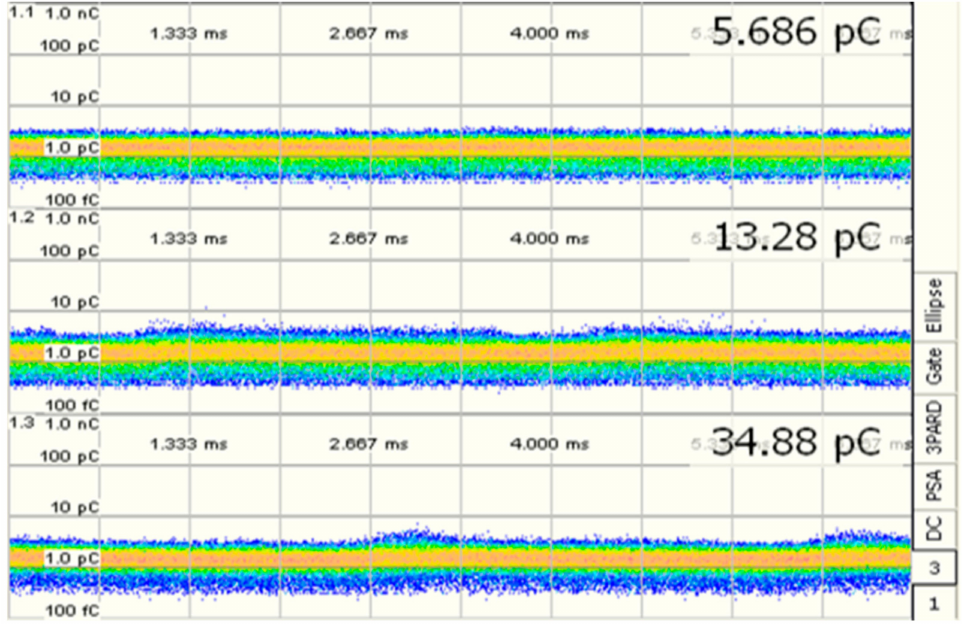
Figure 14. Synchronous multi-channel measurement and separation of PD After oil terminated (60 min).